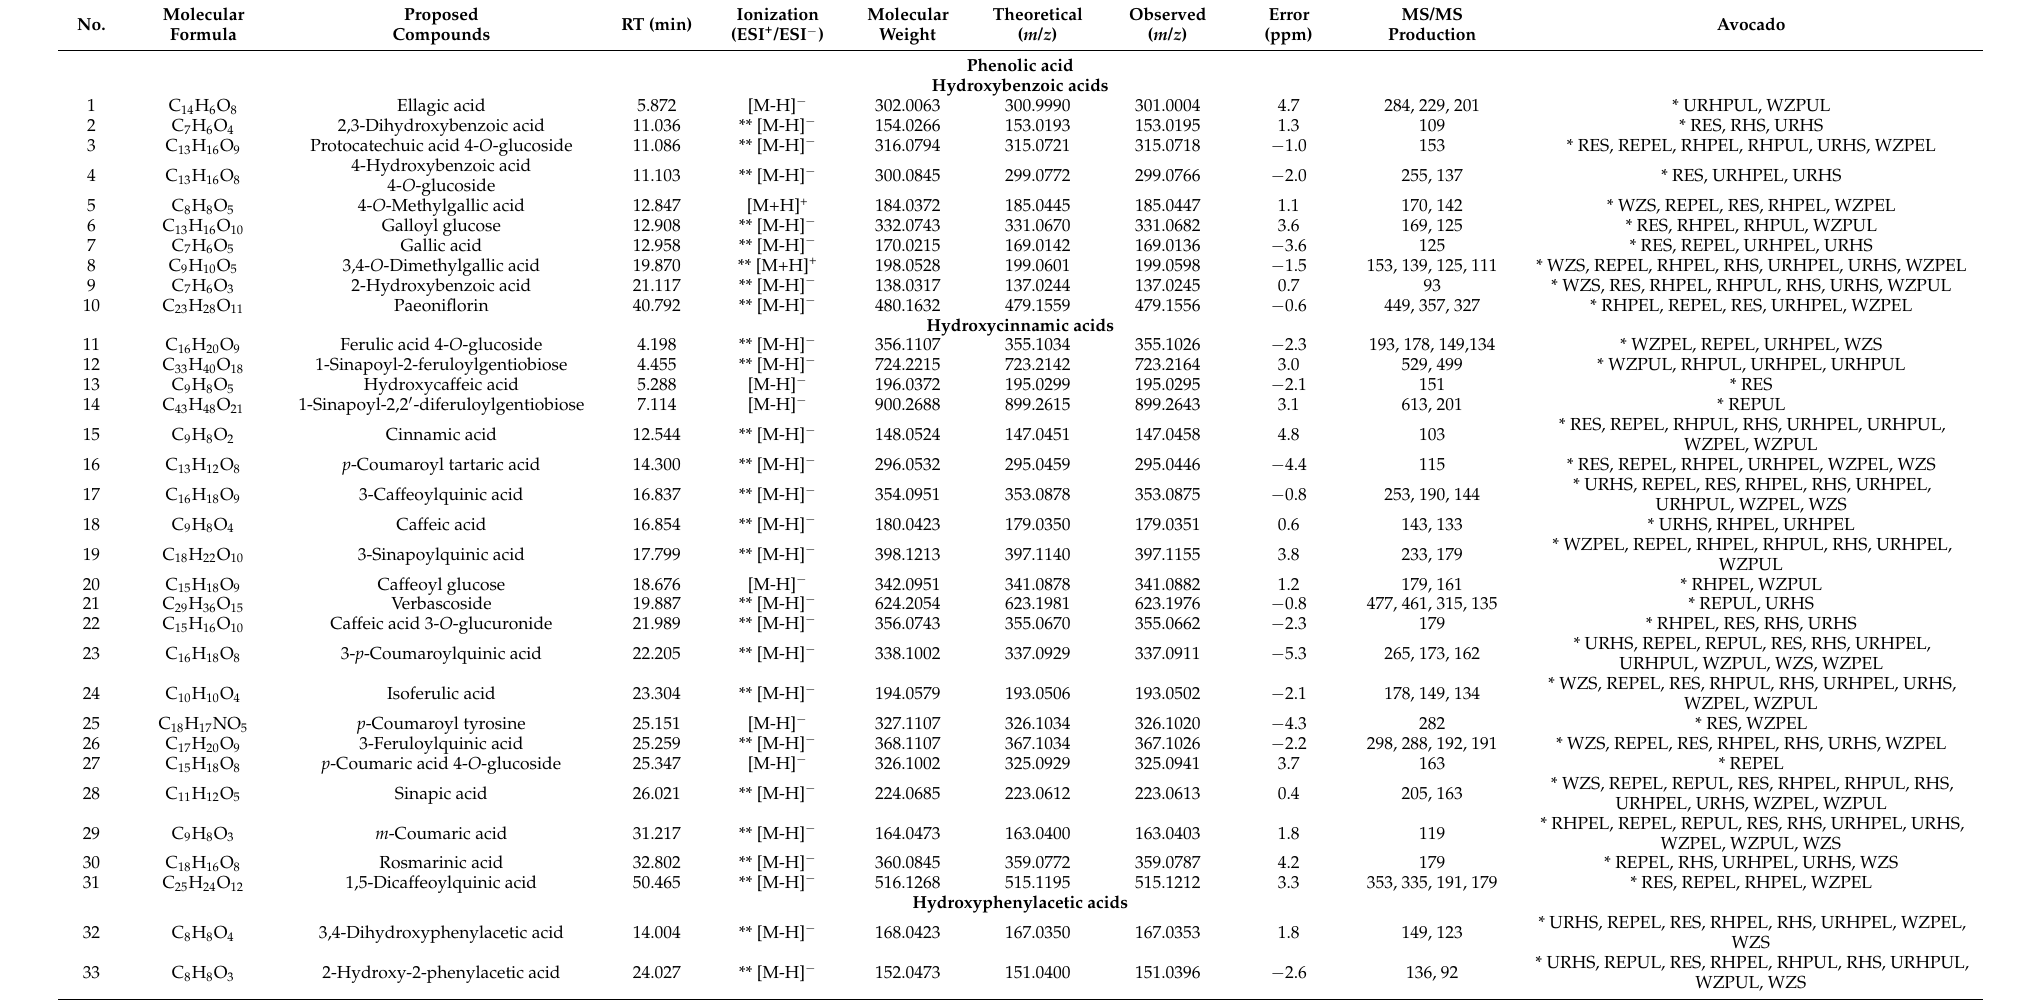
Table 3. Characterization of phenolic compounds in different avocado samples by